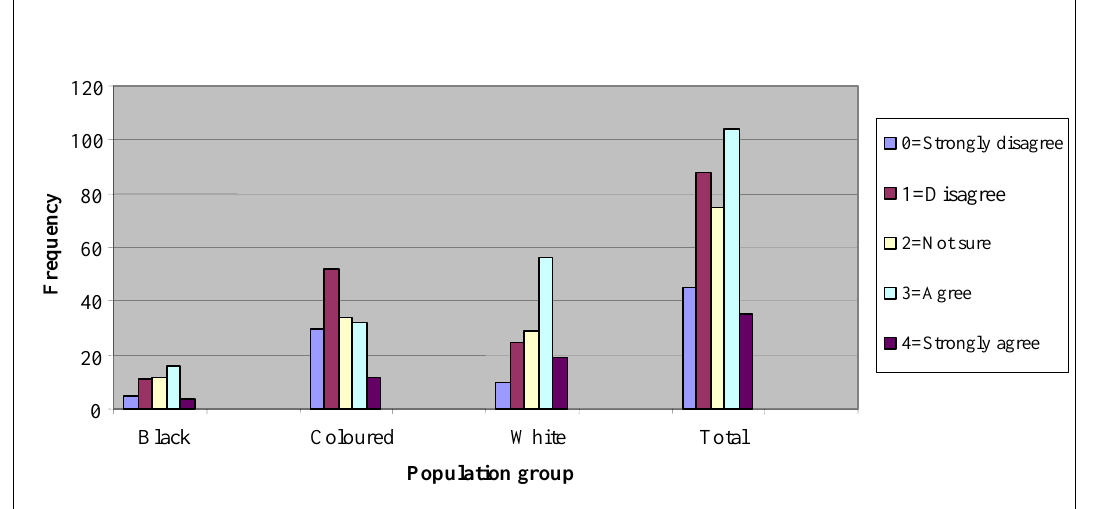
Respondents' perceptions regarding entrepreneurs relative to managers according to population